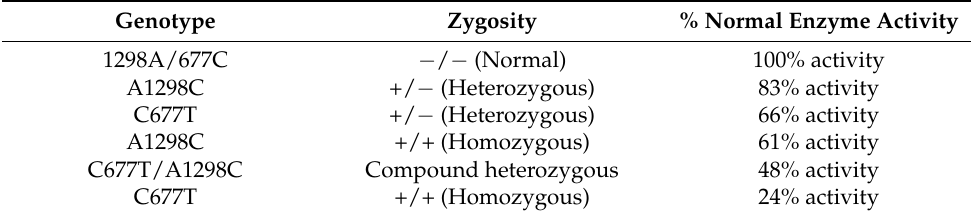
Table 1. Percentage of enzyme activity: percentage of normal MTHFR enzyme activity in the presence of different MTHFR gene mutations ( Adapted from: Iverson Genetic Diagnostics Incorporated, 2016